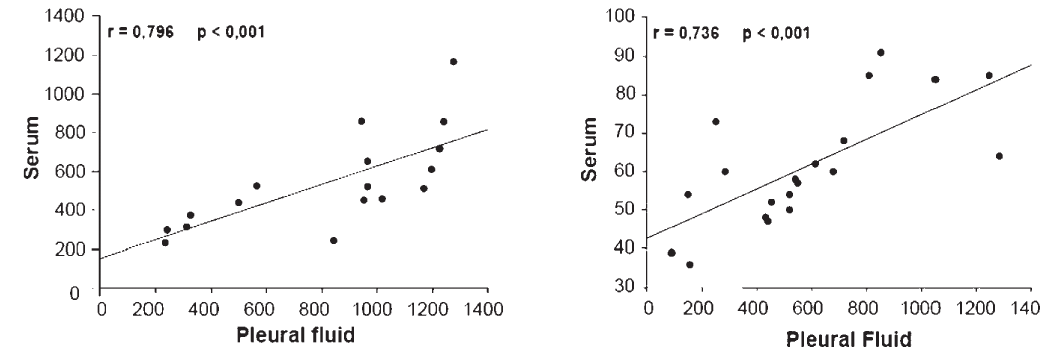
Figure 2 - Comparison of tumor growth factor–beta (TGF- β ) and vascular endothelial growth factor (VEGF) levels in pleural fluid and blood of rabbits submitted to intrapleural injection of small-particle talc and mixed talc,